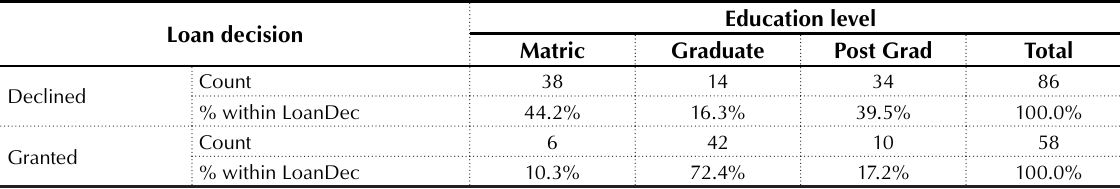
Table 3. Educational level